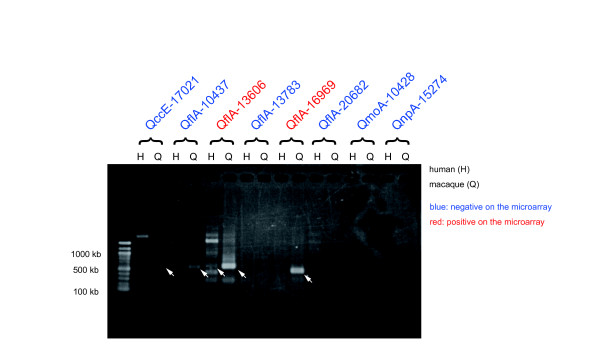
RT-PCR gel images for the expression of the intergenic transcripts in the human (H) and the macaque (Q) brain. Transcript names indicate whether the expression was detected by the microarray experiments (red) or not (blue). Expected PCR products are marked by the white arrows.